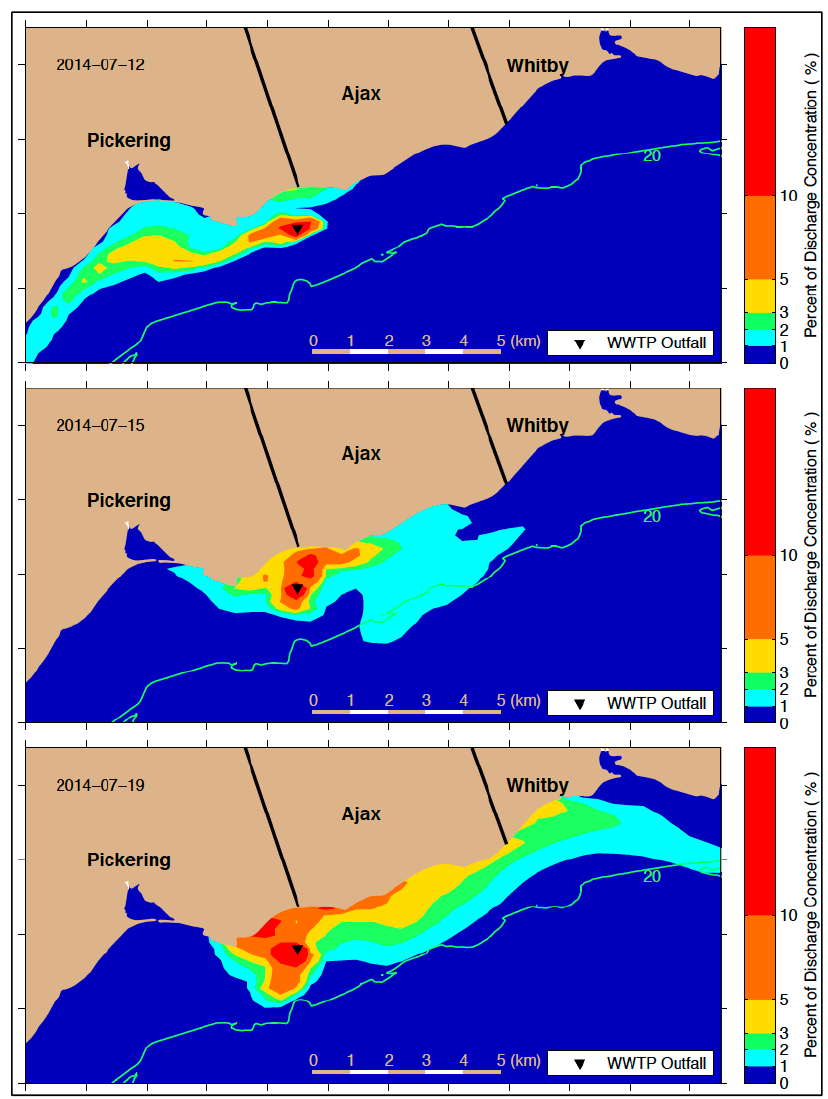
Figure 9. Simulated conservative tracer concentration, averaged over the water column and over the day and expressed as a percentage of the discharge concentration. Results illustrate variation in the Duffin Creek WWTP plume for three dates in 2014. The green line is the 20-m depth representing the approximate lakeward extent of colonization by Cladophora and taken as the separation of nearshore and offshore waters. Model results are from run#2.